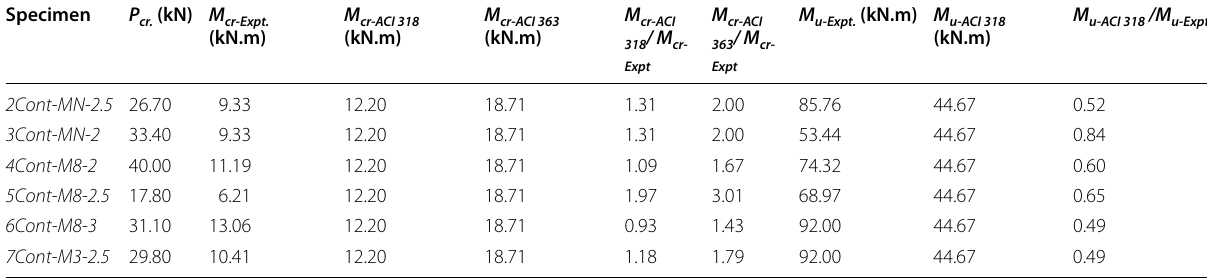
Table 4 Comparisons of cracking